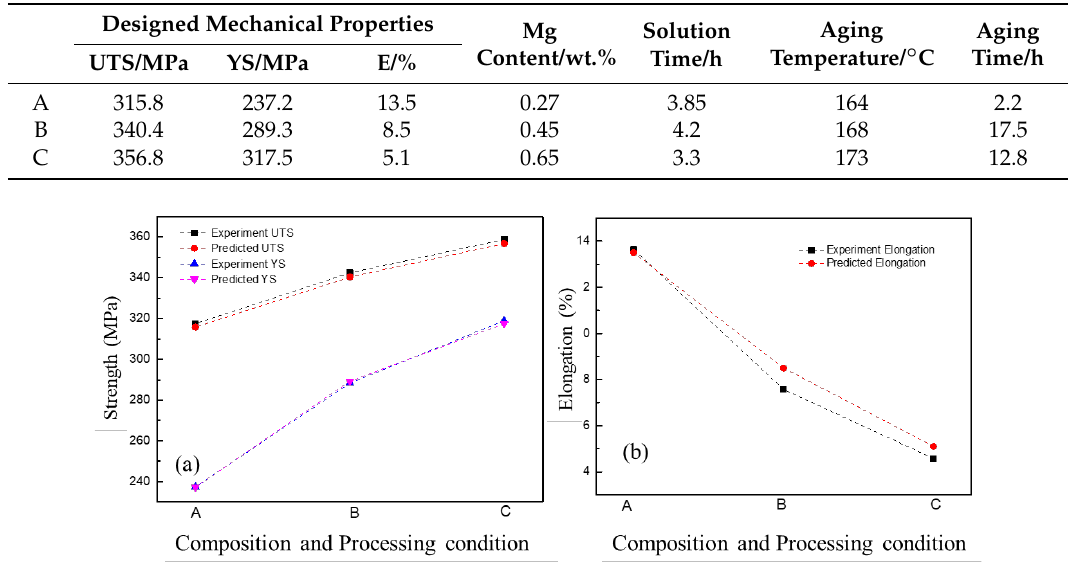
Figure 10. The comparison of experimental and predicted properties: ( a ) Strength and ( b ) elongation.